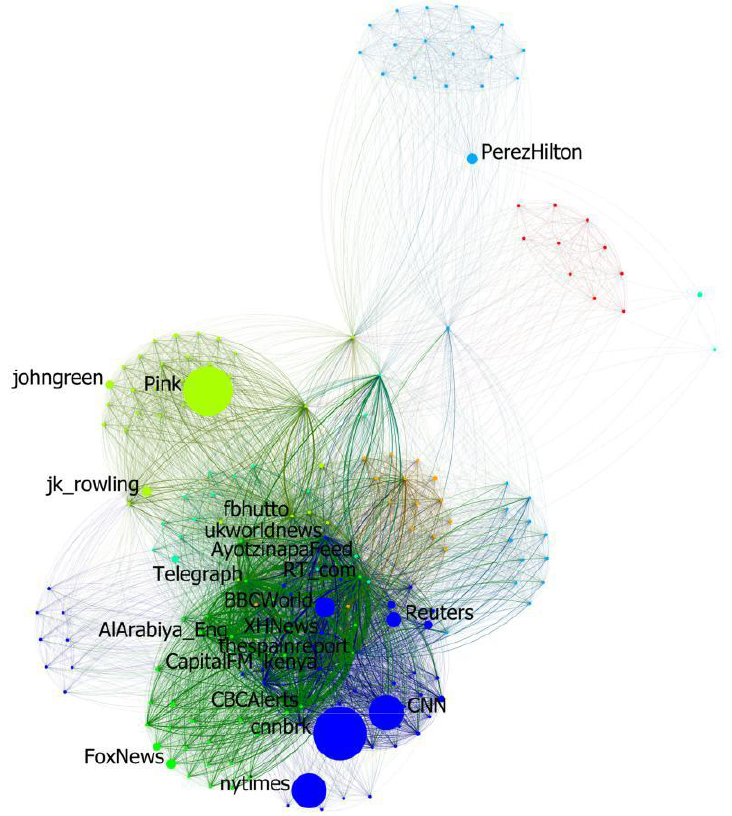
Figure 4. Thematic affiliation network for Twitter ( N = 188, 7